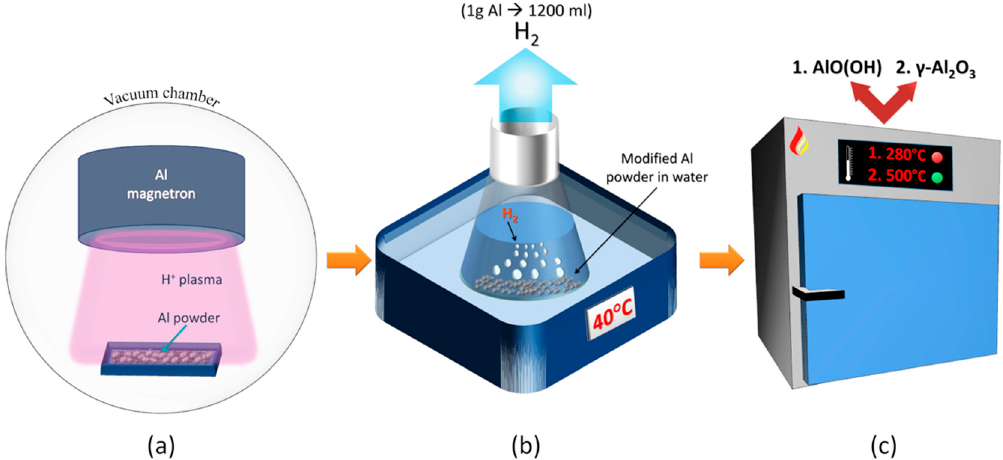
Figure 1. ( a ) Surface of the aluminum powder was modified under hydrogen plasma, with a magnetron as the plasma source. ( b ) Pure hydrogen and a mixture of boehmite and aluminum hydroxide were produced after the complete reaction between the modified aluminum powder and heated water. ( c ) Boehmite and gamma alumina were produced after the initial byproduct of the aluminum/water reaction was heated to 280 and 500 °C, respectively.